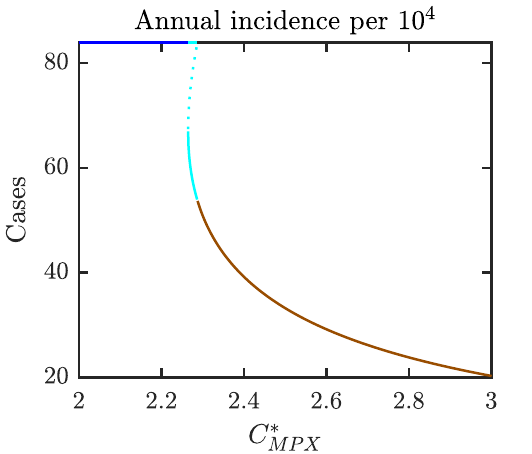
Fig 18. MPX incidence in a population that uses optimal voluntary vaccination rates; β = 0.18 and other parameters as specified in Table 1. The lines are color coded corresponding to the regions shown in Fig 10 which shows a diagram for Nash equilibria as e and C � vary. Blue: 0 is the only NE and it is CSNE. Brown: positive ψ MPX the only NE and it is CSNE. Light blue: three NEs, 0 and the larger NE are CSNE.